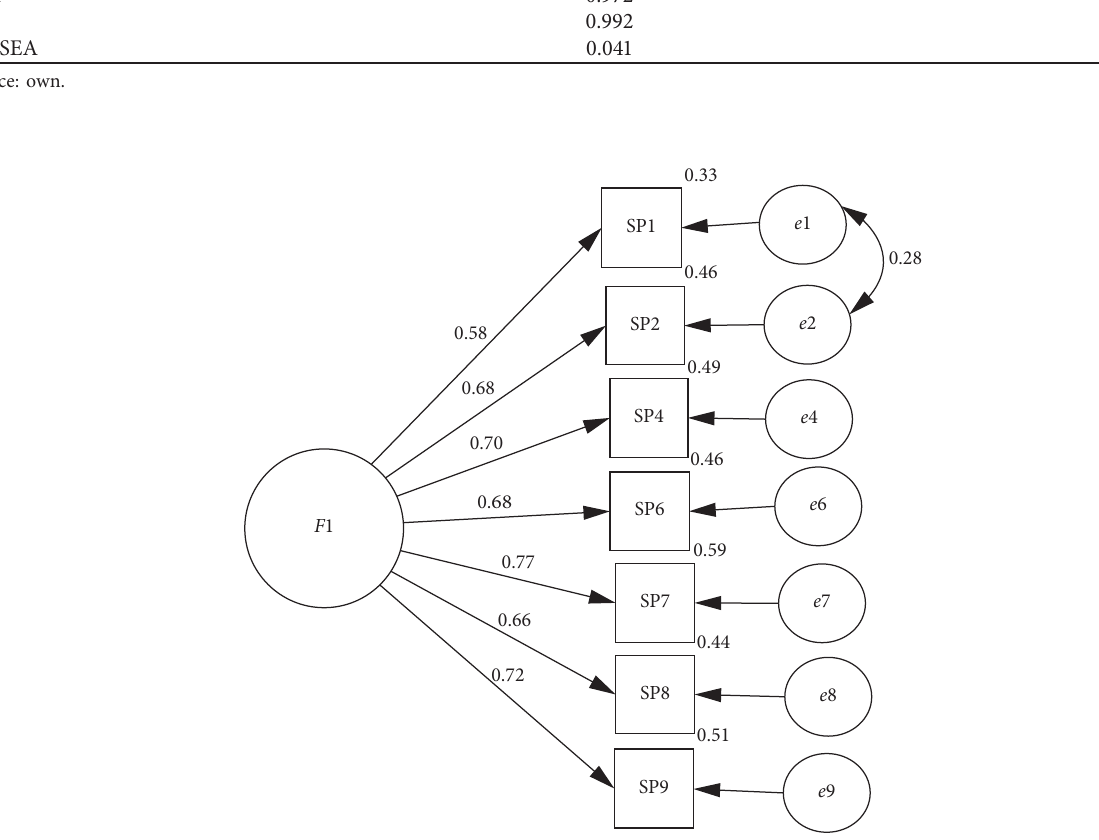
Figure 1: Model of smartphone